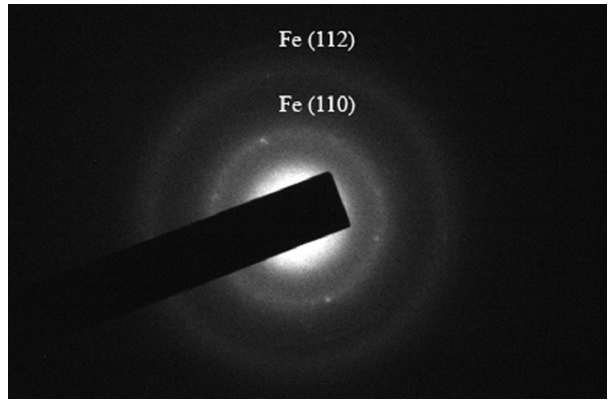
Figure 9. SAED (selected area electron diffraction) pattern showed pure iron phases, no diffraction point of iron oxides was detected.